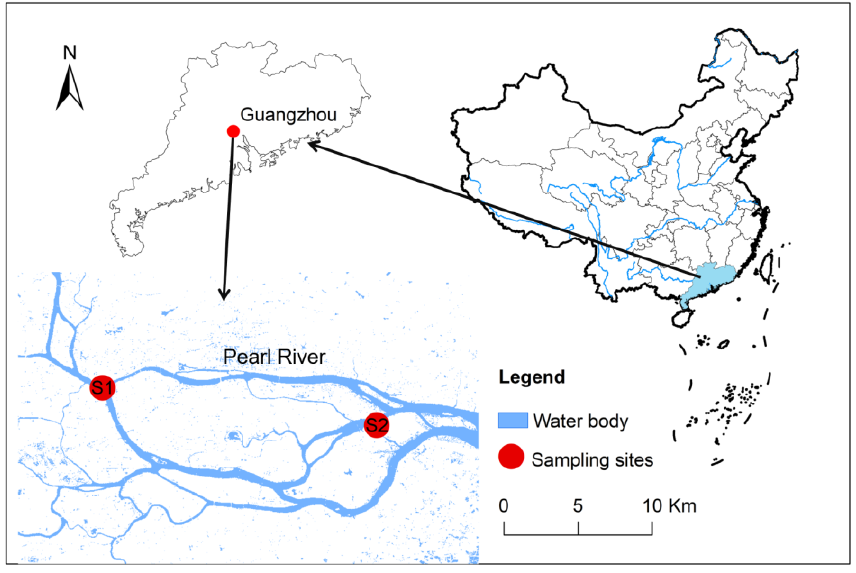
Figure 1. Study area in the Guangzhou section of Pearl River.